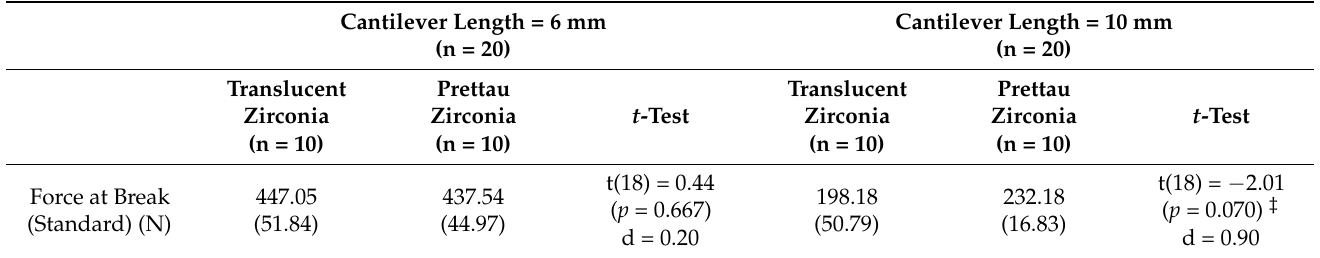
Table 3. Force at break (standard) (N) according to type of zirconia stratified by cantilever length (6 mm and 10